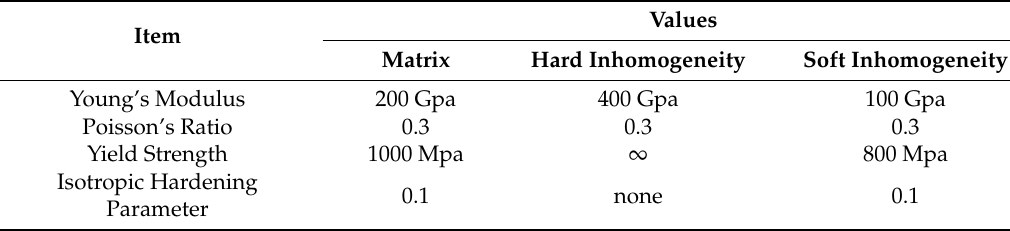
Table 1. Material properties.